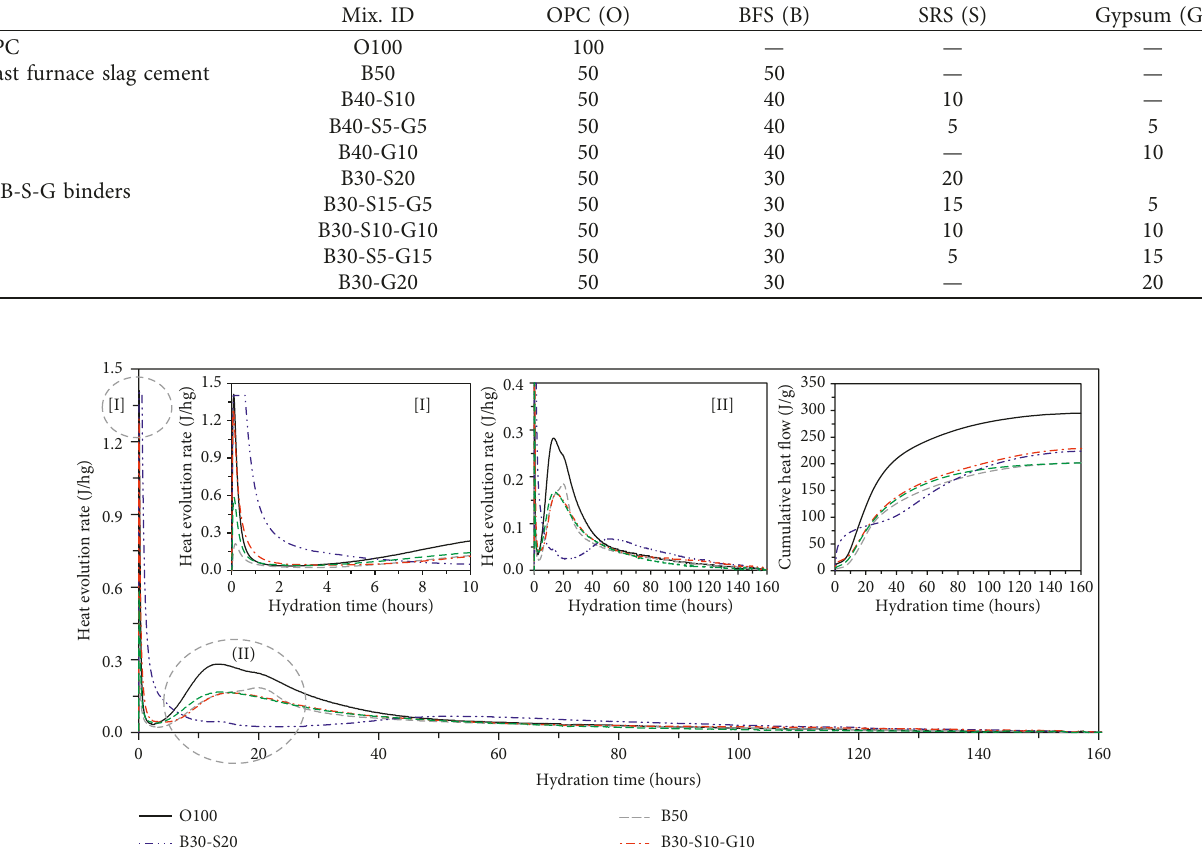
Figure 3: SEM image of the particle. (a) OPC. (b) Gypsum. (c) SRS. (d) BFS. Table 2: Mixture proportions of binders (unit %).